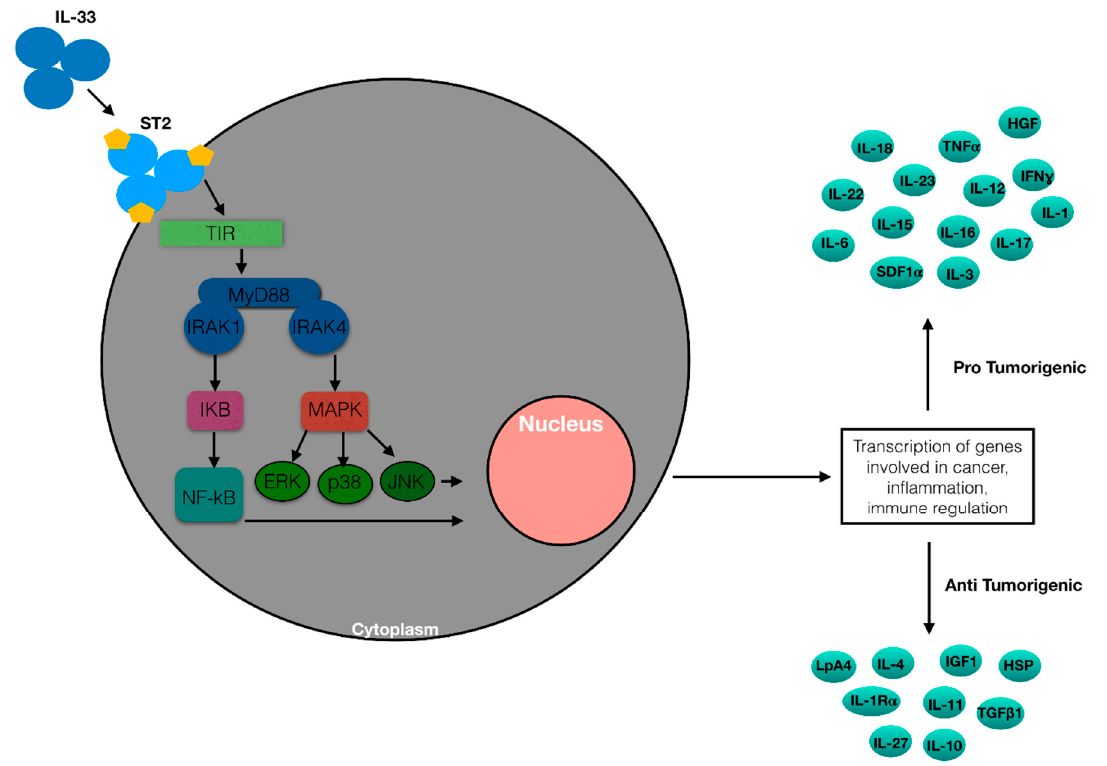
Figure 2. ST2 / IL-33 immune cells signaling pathway. IL-33 either binds to the ST2 receptor, recruiting MyD88 to its intracellular domain. MyD88 binding recruits IL-1R-associated kinase (IRAK) 1 and 4, leading to either the NF- κ B or MAPK pathway being activated. Their activations promote inflammatory cytokine expressions. ST2 / IL-33 signaling has been shown to promote Treg and immune system cells function and expansion through enhancing TGF- β 1-mediated di ff erentiation though a p38-dependent mechanism. ST2 / IL-33 link activates the transcription of several genes involved in tumorigenesis, inflammation and immune regulation.